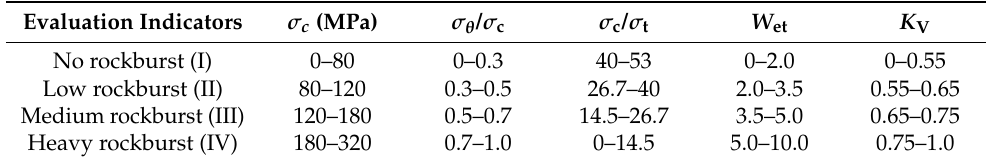
Table 2. Single-indicator classification standards for rockburst intensity.